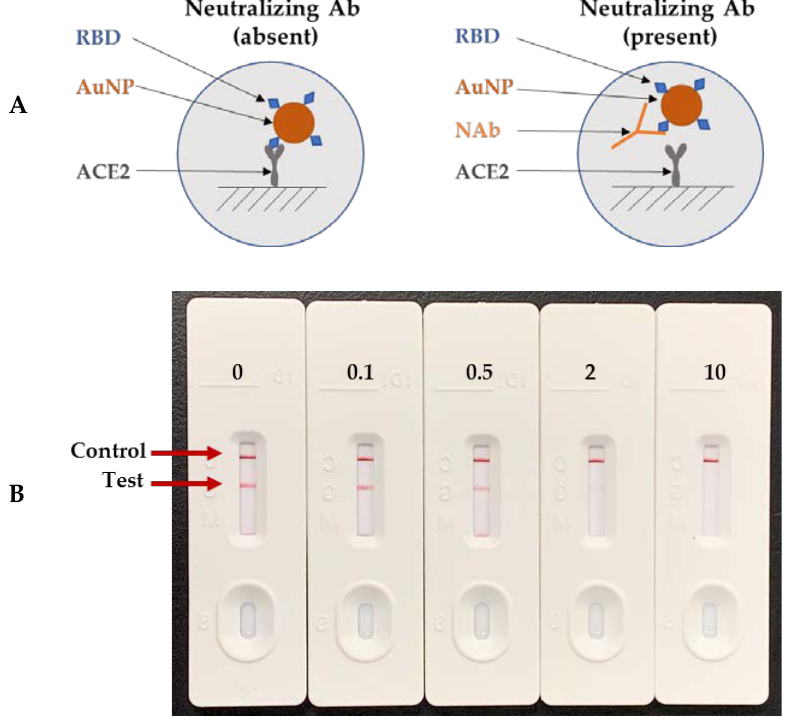
Figure 5. Neutralizing antibody test principle and images of the representative test devices. ( A ) Lat- eral flow cassette neutralization assay principle. ( B ) Photographs of a representative set of lateral flow neutralization test devices. (Units = neutralizing antibody concentration in μg/mL).